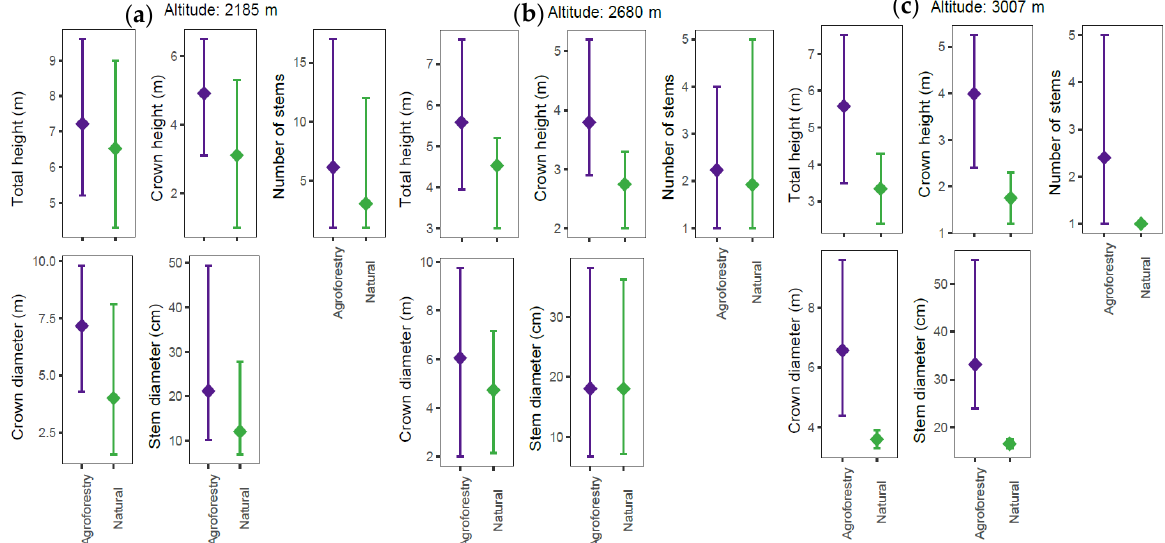
Figure 6. Dendrometry of the Tara tree: tree height, crown height, number of stems, crown diameter, and stem diameter. Altitude 2185 m ( a ), altitude 2680 m ( b ), and altitude 3007 m ( c ) for natural and agroforestry environments. The mean was followed by the bootstrap method’s non-parametric confidence interval (CI: 95%).